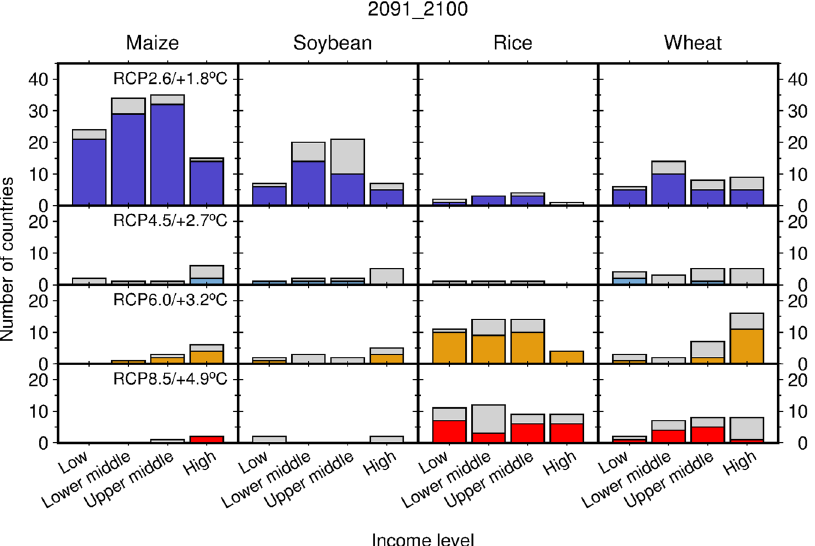
Figure 4. The number of countries showing the highest levels of yield growth for 2100 (the average for the period 2091–2100) by level of temperature increase and income level. The RCP corresponding to each level of temperature increase is also presented. Gray bars denote the number of countries producing a crop of interest under the aforementioned combinations of temperature increase and income. Colored bars denote the number of countries for which over 70% of the 15 ensemble members (5 GCMs × 3 SSPs) showed consistent results. The sum of bars over the four panels in a column denotes the number of countries producing a given